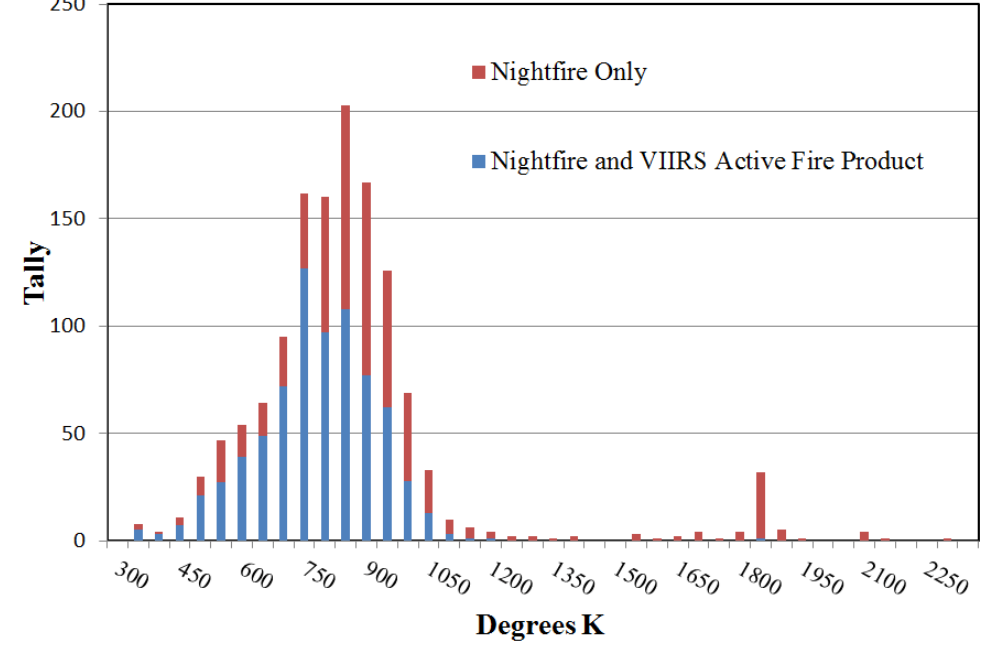
Figure 15. Histogram of temperatures for the pixels detected by the VIIRS active fire product and Nightfire (blue) vs. Nightfire only (red). Data are from the 19 June 2013 Sumatra